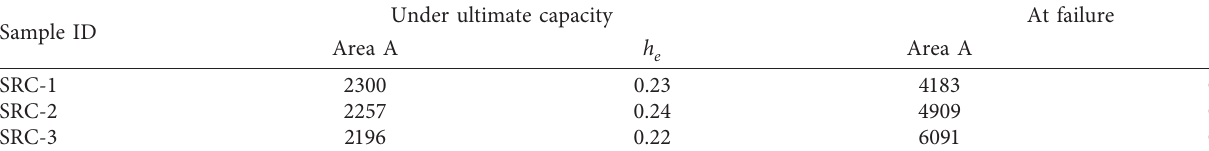
Figure 16: Calculation of h Table 6: Energy dissipation coefficients.